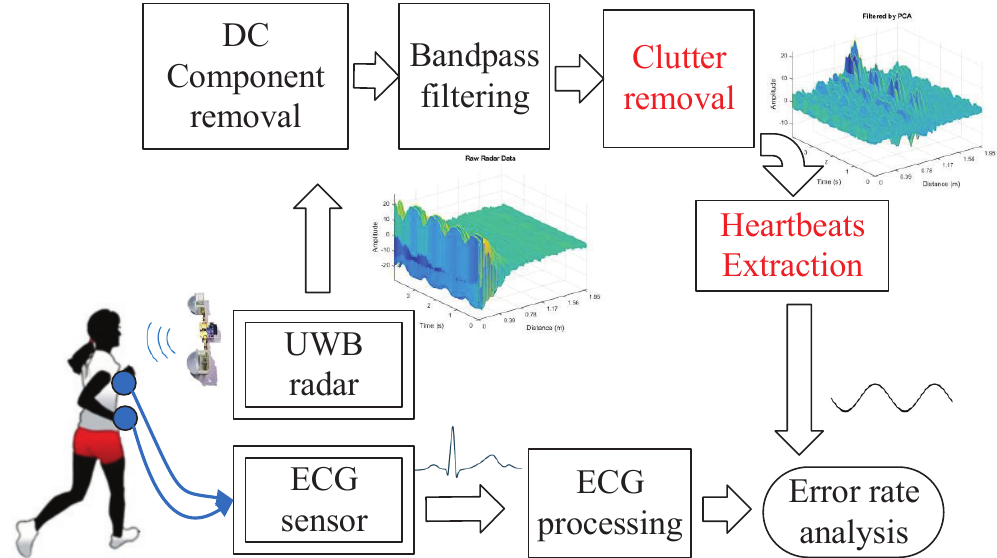
Figure 1. Processing flow of impulse radio-ultra wideband radar data and ECG signal.